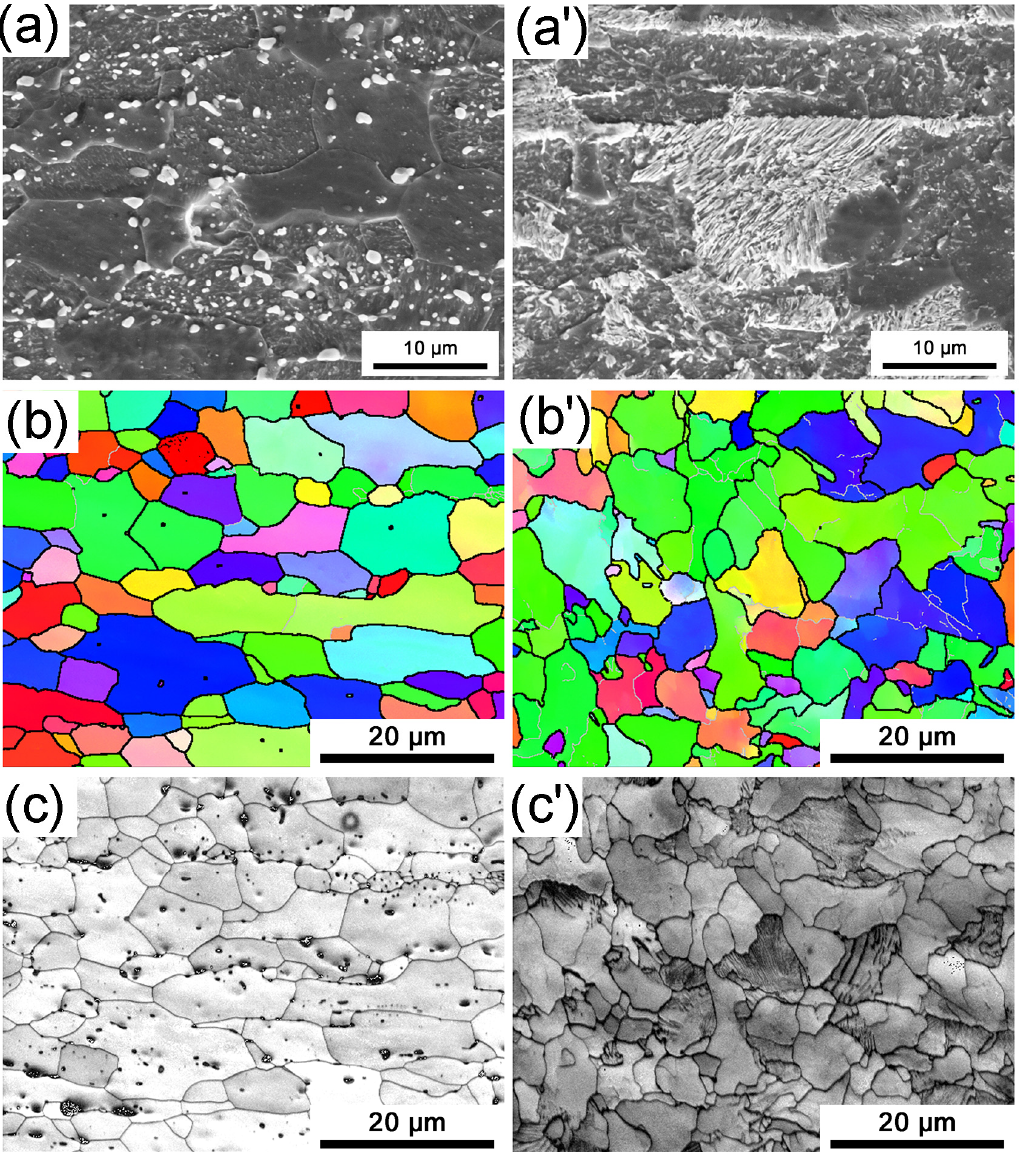
Figure 1. The original microstructure of hot-stamping steel for two processes: SEM images of the ( a ) traditional process and ( a ′ ) CSP process, EBSD inverse pole fi gure (IPF) maps of the ( b ) traditional process and ( b ′ ) CSP process, and corresponding band contrast of the ( c ) traditional process and ( c ′ ) CSP process.